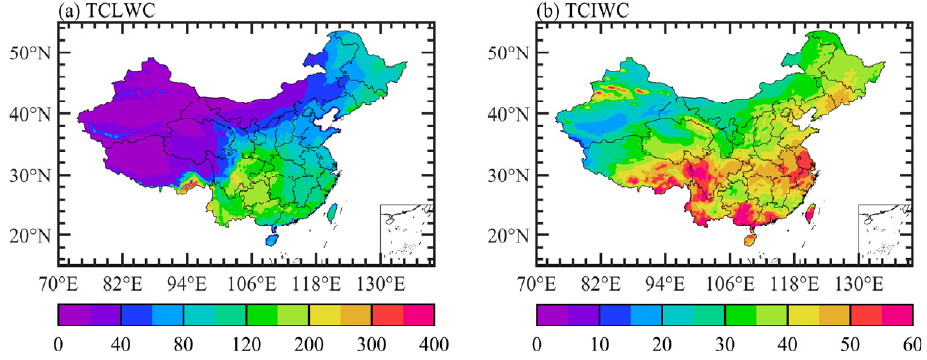
Figure 6. Spatial distribution of monthly average total column of ( a ) cloud liquid-water content (TCLWC) and ( b ) cloud ice-water content (TCIWC) over China during the summers of 1979–2020 (unit: g·m − 2 ).